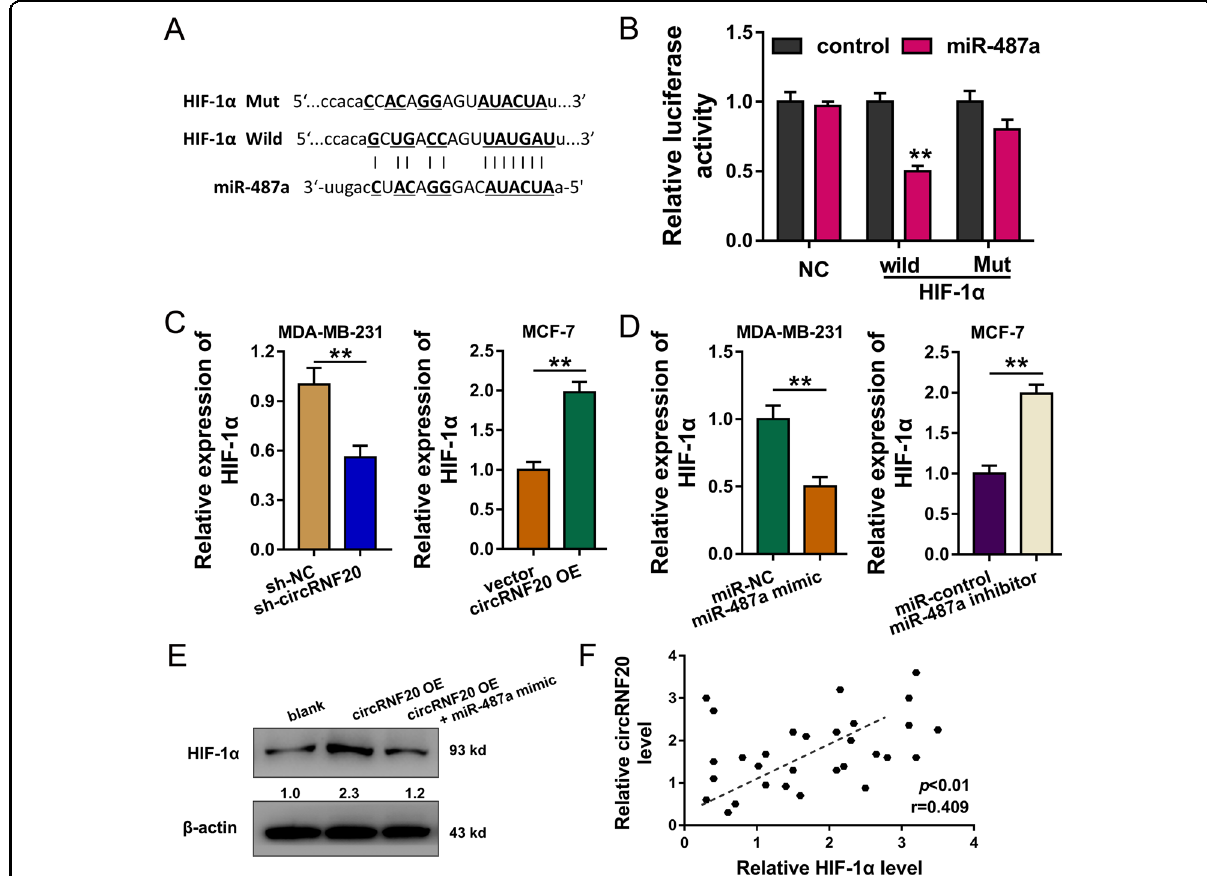
Fig. 4 circRNF20/miR-487a targets HIF-1 α in BC cells. a Online bioinformatic prediction (http://starbase.sysu.edu.cn/) indicated the targeting of miR-487a towards 3 ’ -UTR of HIF-1 α mRNA. b Luciferase reporter assay unveiled the molecular combination of miR-487a with HIF-1 α mRNA wild type. c RT-PCR showed the HIF-1 α mRNA level with the transfection of circRNF20 knockdown and circRNF20 overexpression in BC cells. d RT-PCR showed the HIF-1 α mRNA level with transfection of miR-487a overexpression (mimic) and miR-487a repression (inhibitor). e Western blot analysis showed the HIF-1 α protein with transfection of circRNF20 overexpression and miR-487a mimic. f Spearman ’ s rank correlation coef fi cient showed the correlation with the HIF-1 α and circRNF20 in the BC patients samples. ** p < 0.01 vs.